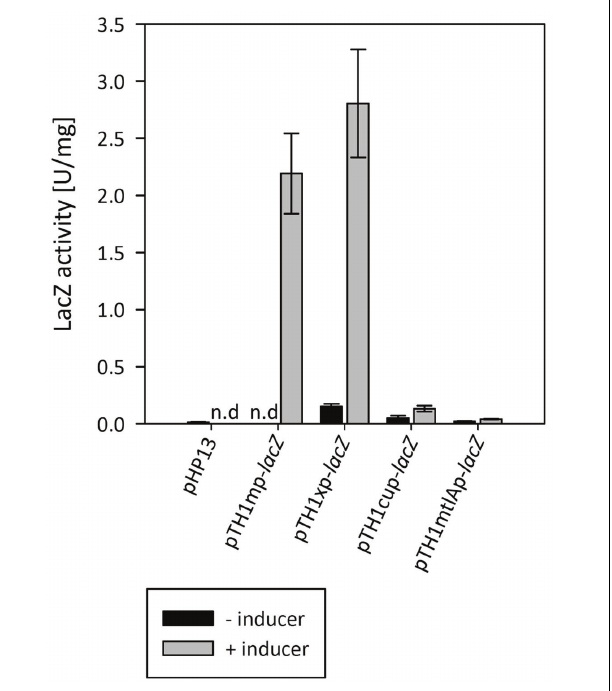
FIGURE 3 | Screening of various inducible gene expression systems with lacZ used as reporter gene. The methanol, xylose, mannitol and copper inducible systems were compared. Means of triplicates with standard deviation are shown, n.d – no